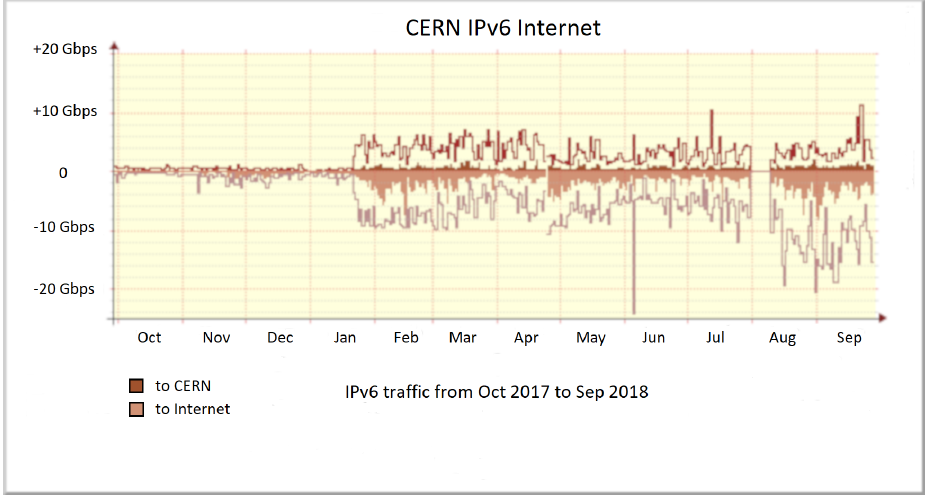
Figure 1. IPv6 tra ffi c through the CERN central firewall, period Oct 2017 to Sep